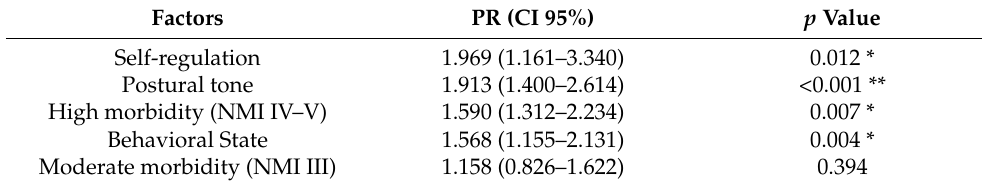
Table 3. Multivariate analysis of factors affecting oral feeding